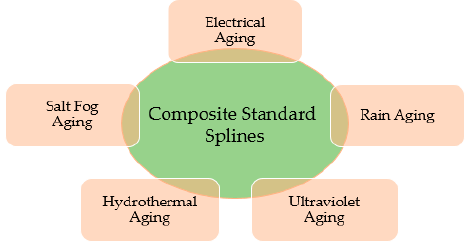
Figure 1. The multifactor aging of composites material [4].